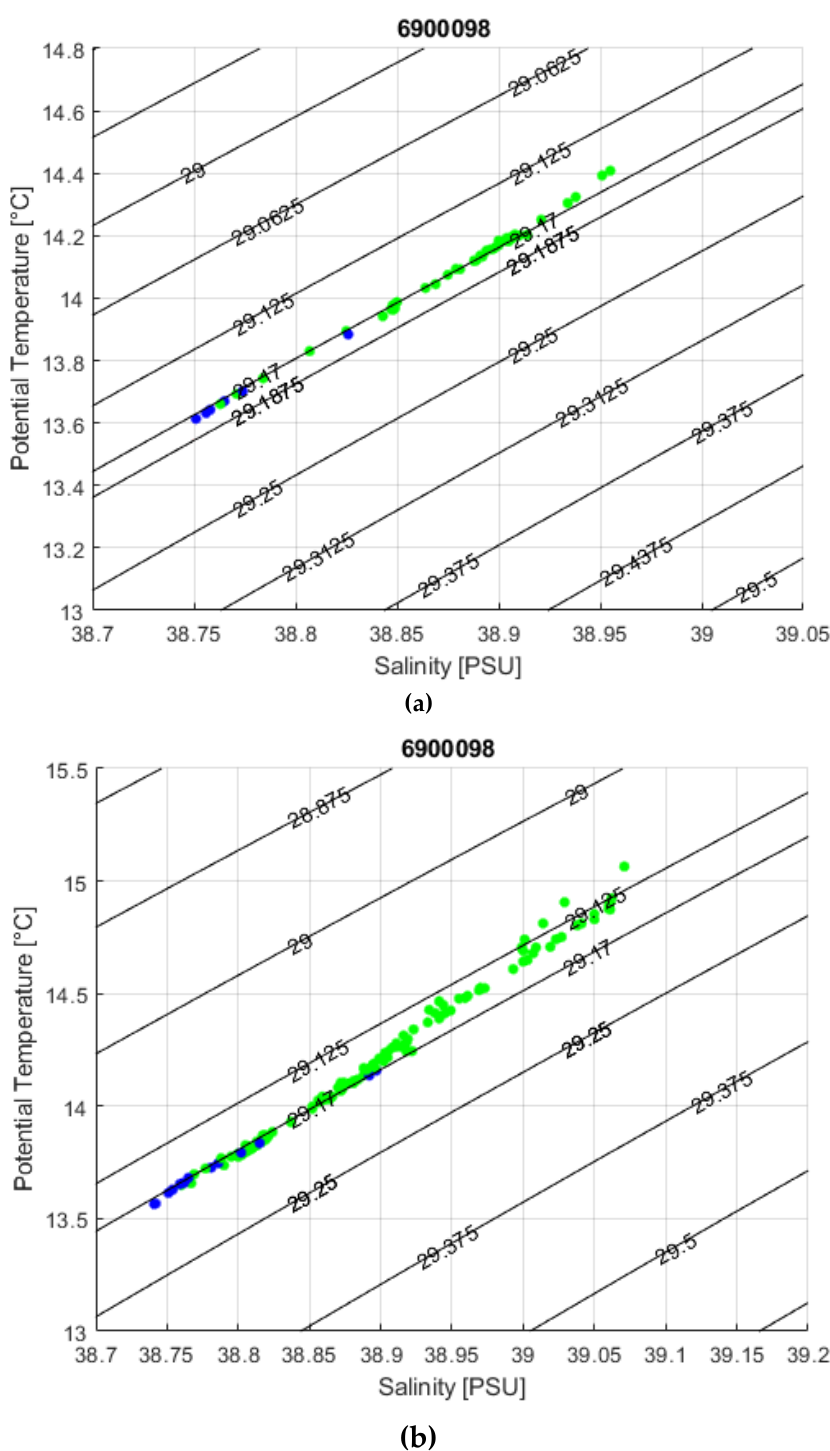
Figure 11. ( a ) The temperature and salinity (T / S) plot for float WMO 6900098 from 20 January to 20 February 2006 indicates LDW formation. The additional density line with a potential density value of 29.17 kgm − 3 shows the upper deep-water boundary density which corresponds to approximately 1000 m depth for the NWLS [23]. ( b ) T / S plot for float WMO 6900098 for March 2006 indicates a mixture of LDW and ‘lower range’ LIW formation. Green dots represent depths from 100 to 500 m while blue dots represent depths from 500 to 600 m. (2) LDW formation took also place from the end of February until mid-March 2004 within another cyclonic mesoscale eddy located in the western part of the RG. Hoevmueller plots for DJFMA